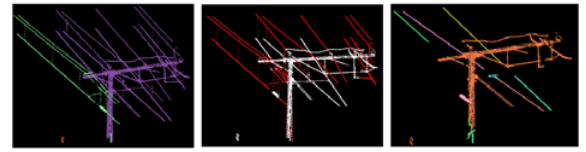
Figure 2 Typical connected component only based on proximity (left), removal of linear components (middle, red) to remove points on wires (right). Figure 3 Original tree component (a), two seeds found at lower part of stems (b), points coloured by iteration number while growing (c), (d) and (f) are final individual components visualized separately and together in